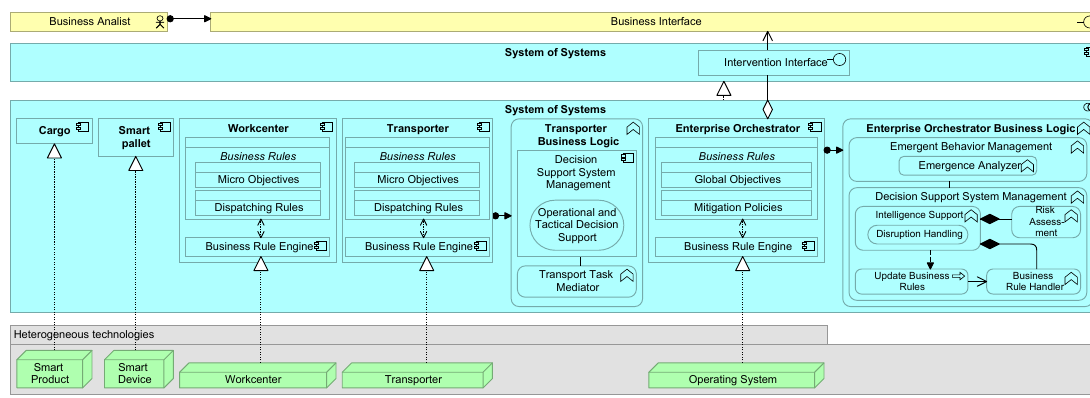
Figure 9. MultimodalLoCo’s enterprise